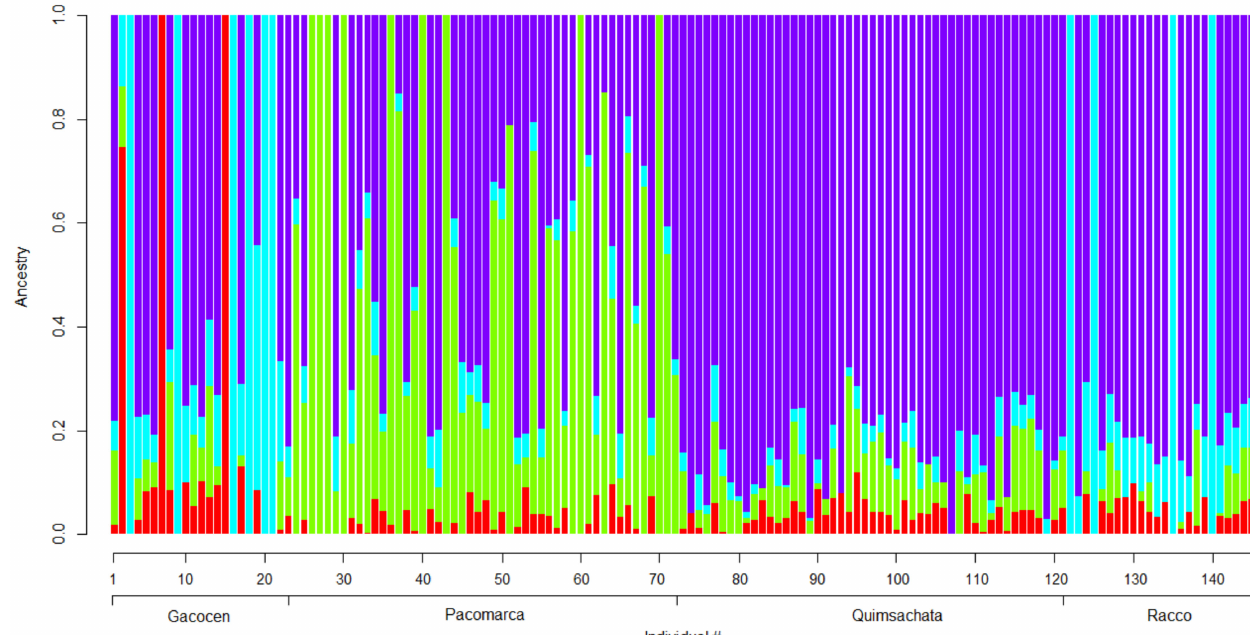
Figure 6. Proportions of admixture per individual for K =